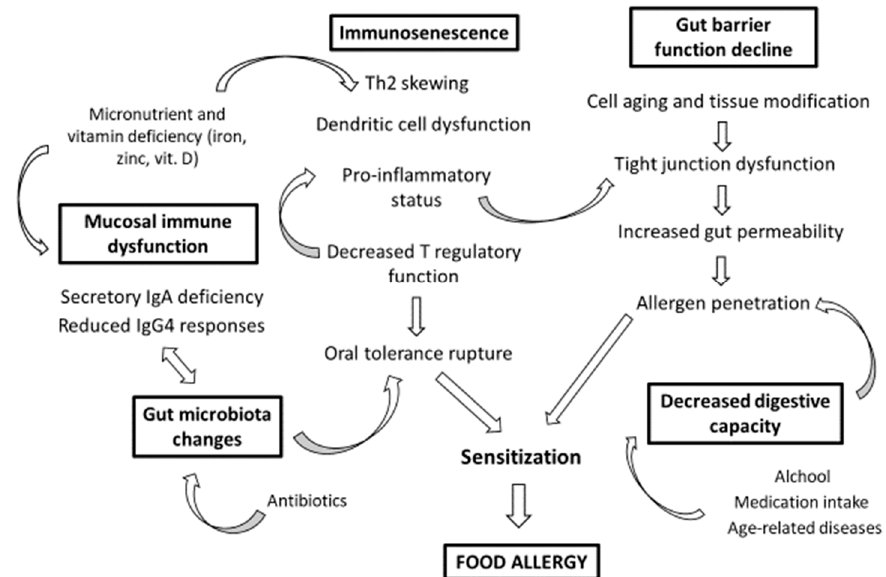
Figure 1. Food allergies in the elderly. The figure shows the main risk factors for the development of a food allergy in the elderly. Immunosenescence and the mucosal immune dysfunction of the gastrointestinal tract are driving forces in the development of food allergies in the elderly. The gut barrier function decline and the compromised digestive properties, as well as the age-related microbiota remodeling, are also central factors for both allergen penetration and sensitization.